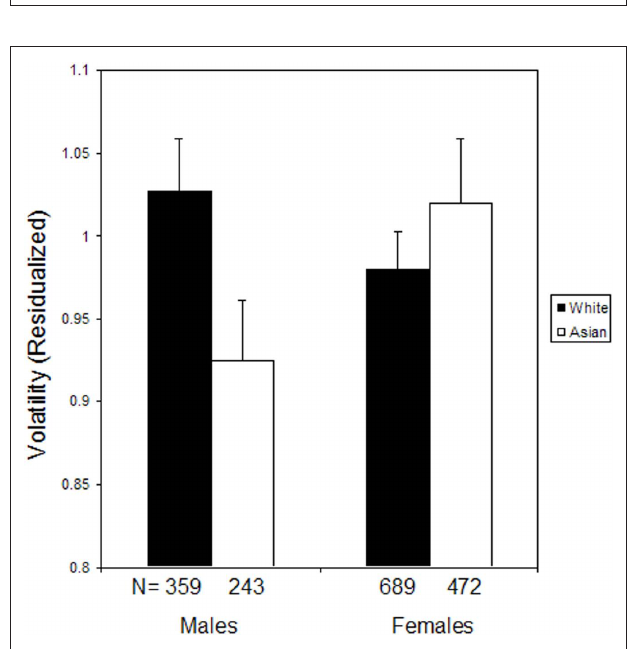
FIguRE 4 | Ethnicity moderates gender differences in Volatility (residualized). Residualized scores are depicted as the scores plus 1, for ease of